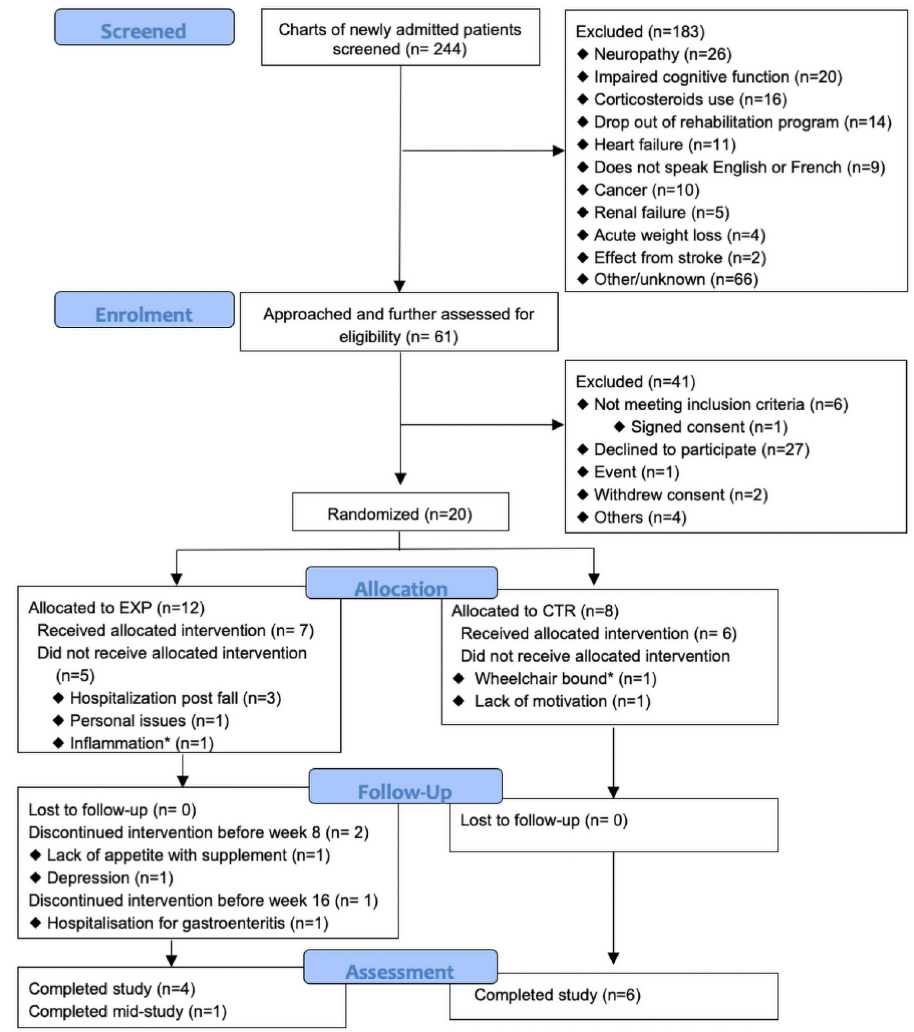
Fig 1. CONSORT flow diagram of the progress of participants through the study phases, conducted between August 2016 and August 2018.